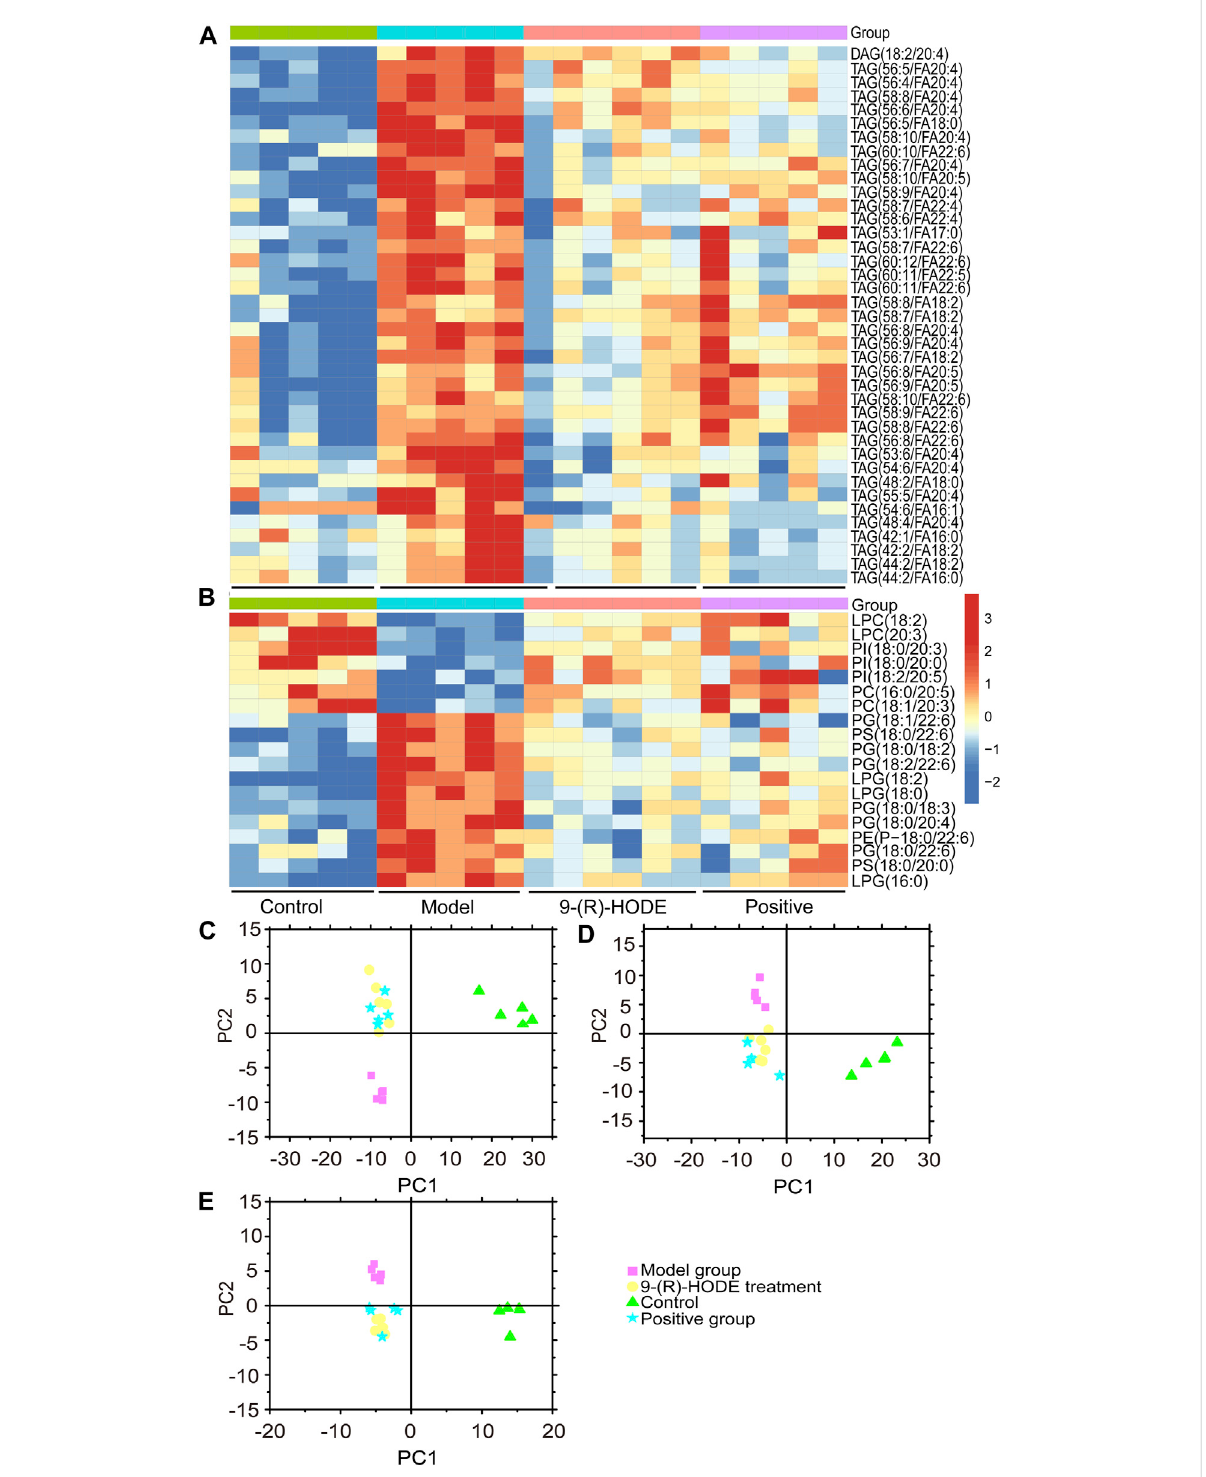
FIGURE 5 (A,B) The representative extracted heatmap of differential lipids in the liver (A: positive mode, B: negative mode). The color scale illustrates the relative abundances across the samples. Blue indicates metabolites that were signi fi cantly downregulated, while red indicates signi fi cantly upregulated metabolites. (C – E) PLS-DA score plots of PC1 vs. PC2 based on the LC ‒ MS/MS data of lipids in the liver (C: positive mode, D: negative mode) and kidney (E: negative